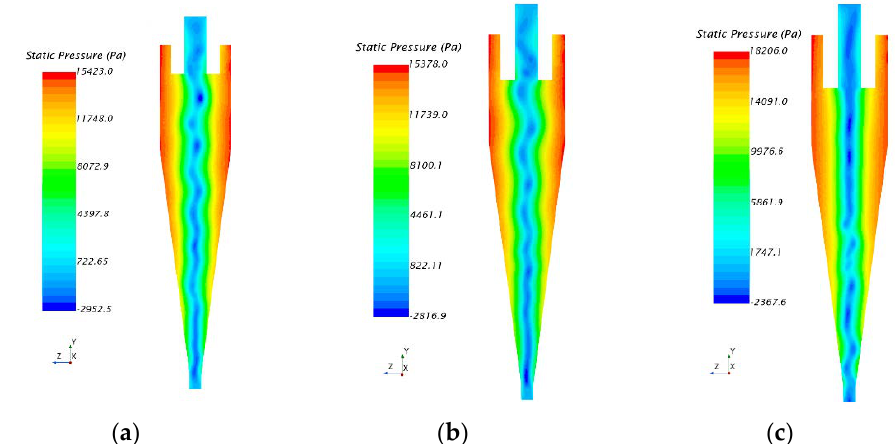
Figure 7. Static pressure at 60 s at an inlet feed velocity of 3 m/s ( a ) VF = 20 mm ( b ) VF = 30 mm ( c ) VF = 35 mm.